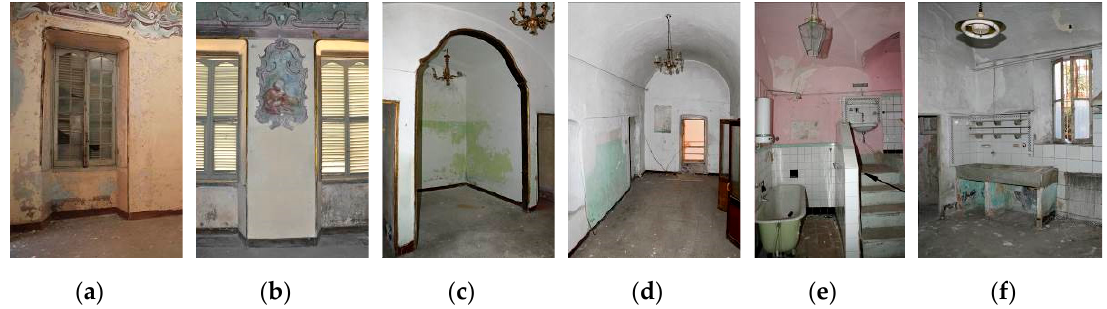
Figure 4. Existing state of conservation of different rooms of the apartment: ( a ) First room, ( b ) second room, ( c ) room with alcove. ( d ) third room, ( e ) bathroom and ( f ) kitchen. The conformation of the apartment best represents the history and evolution of the building,